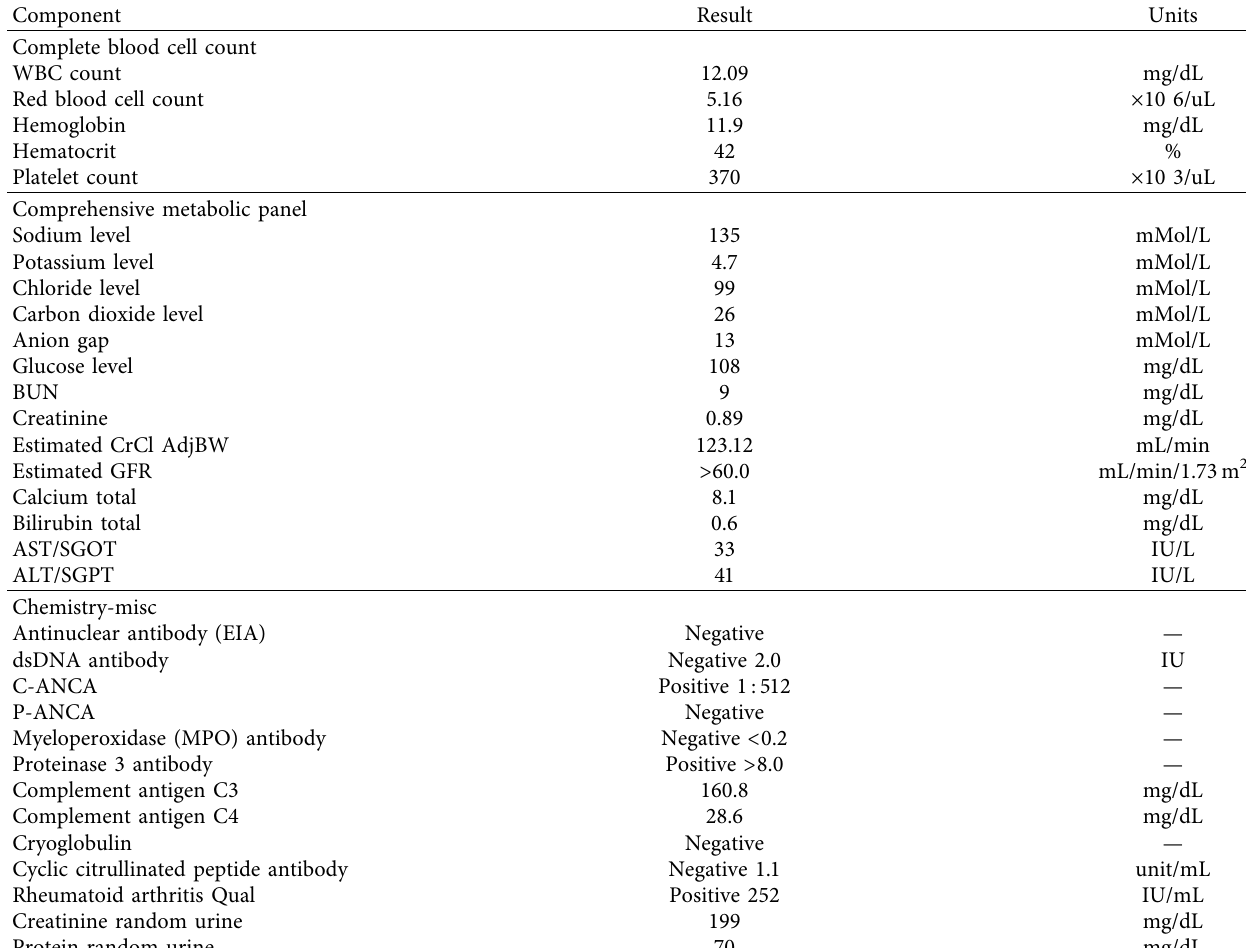
Figure 1: MRI of the brain with and without contrast—small region of focal water restriction at the left mammillary body consistent with a subtle infarct in this area. Table 1: Laboratory